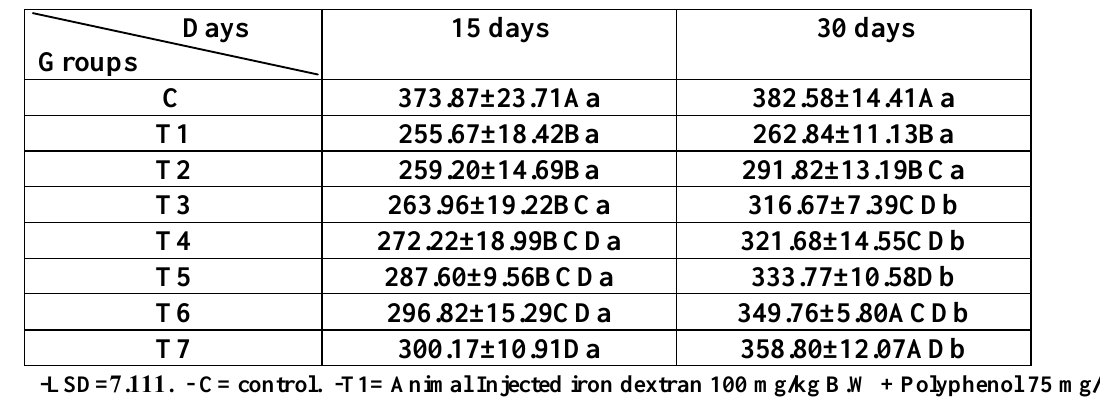
Table 3: Effect of different doses of total polyphenol extracted from Green tea on Serum reduced glutathione (GSH) concentration(µmol/l) of iron overload treated rats.